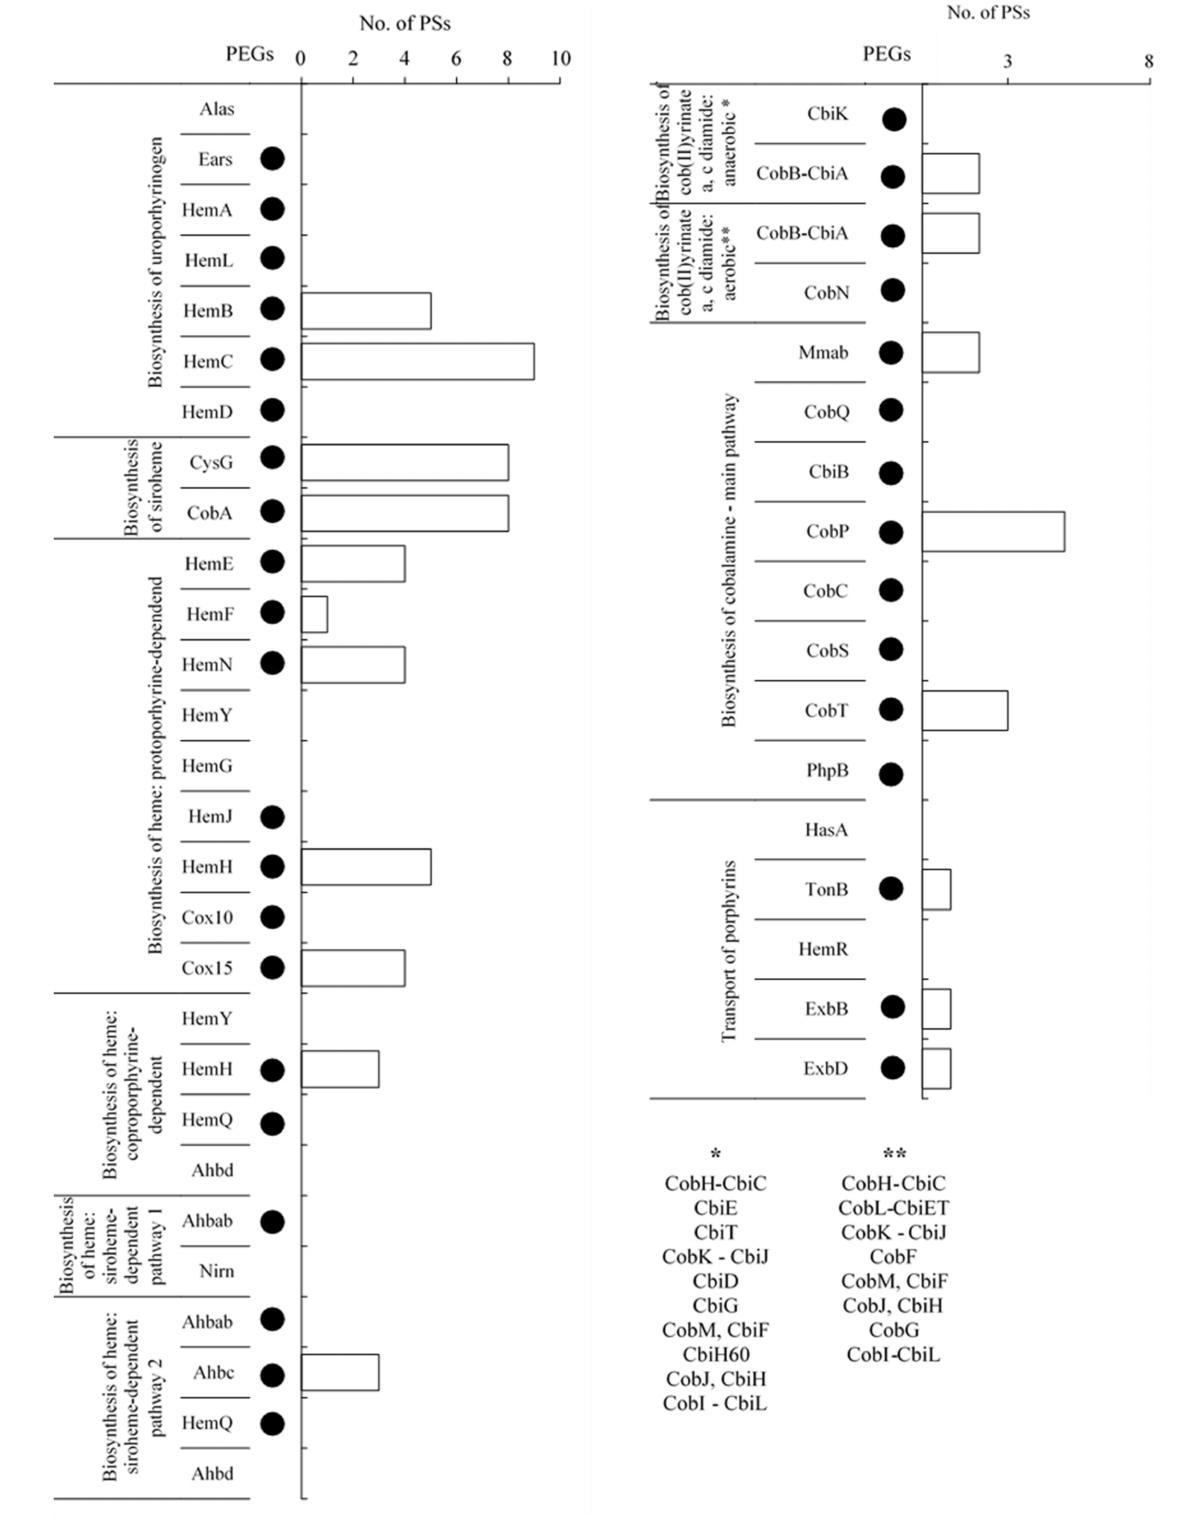
Figure 4. Detection of protein-encoding genes in the metagenome and number of protein sequences identified in the metaproteome of bacterial community involved in the biosynthesis of tetrapyrrole cofactors.* List of enzymes involved in anaerobic biosynthesis of cob(II)yrinate diamide detected neither in metagenome nor in metaproteome of bacterial community. ** List of enzymes involved in aerobic biosynthesis of cob(II)yrinate diamide detected neither in metagenome nor in metaproteome of bacterial